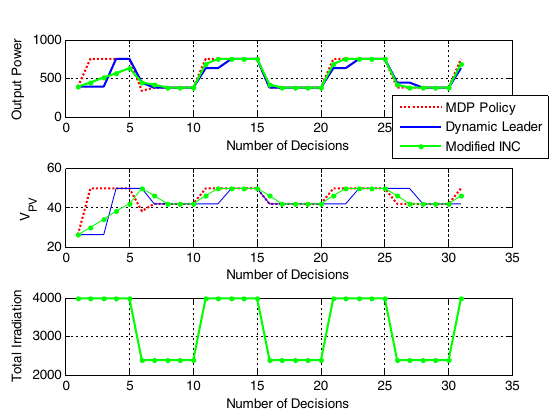
Fig. 8 Irradiance versus photovoltaic voltage under medium frequency